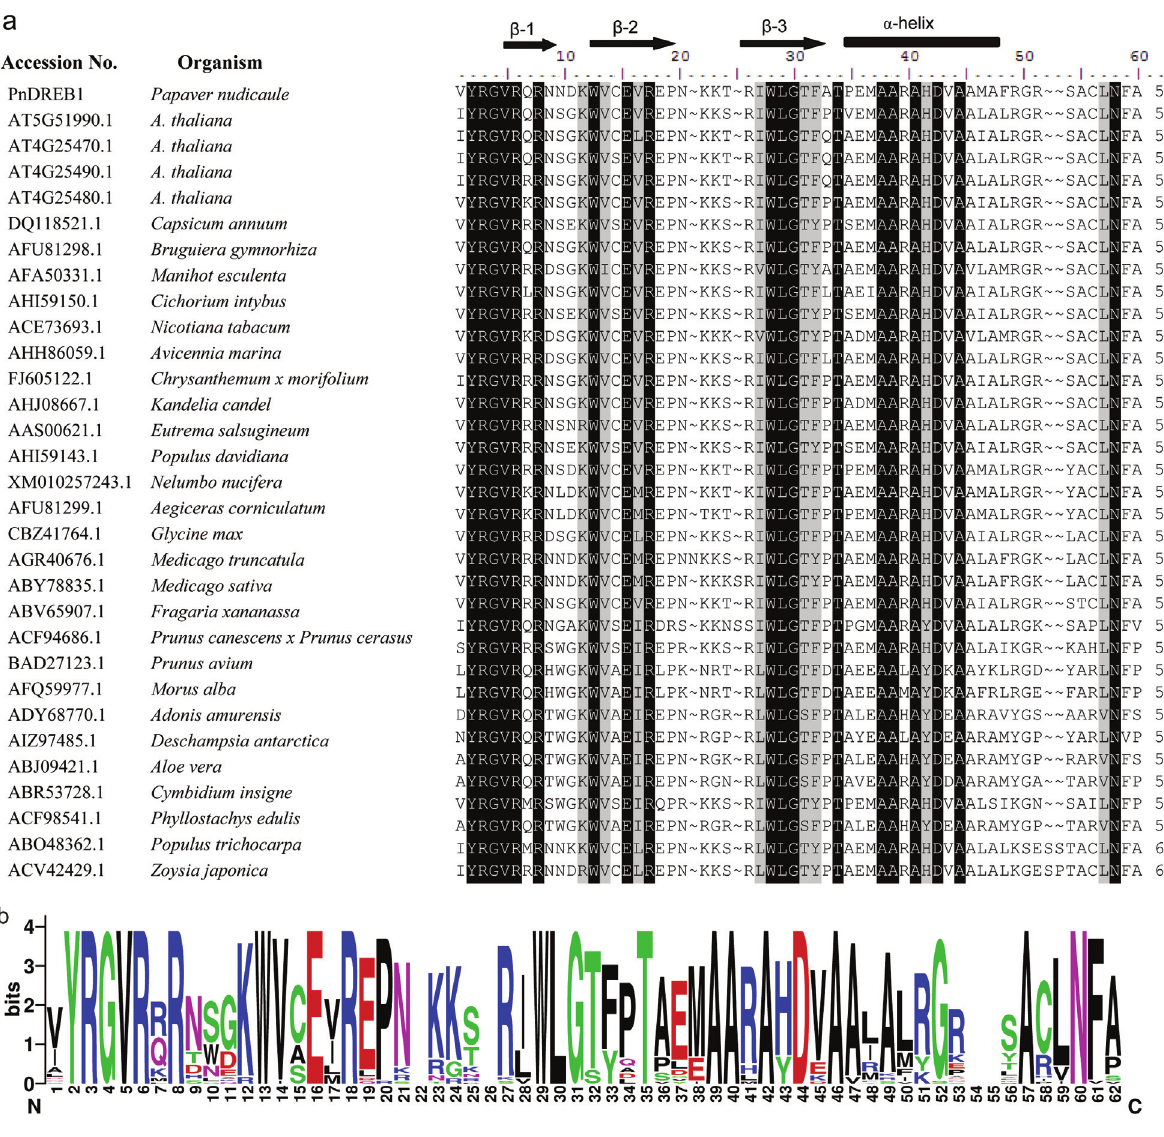
Figure 3 - Comparison of deduced amino acid sequences of AP2/ERF domain of 35 DREB1s from diverse dicot and monocot species. a, multiple align- mentofaminoacidsequencesofAP2/ERFdomain.Blackshadingindicatesidenticalresidues;grayshadingindicateshighlyconservedresidues.b,Motif logo drawn based on the multiple alignment of amino acid sequences of AP2/ERF domain. The overall height of the stack indicates the sequence conser- vation at that position, while the height of symbols within the stack indicates the relative frequency of each amino at that